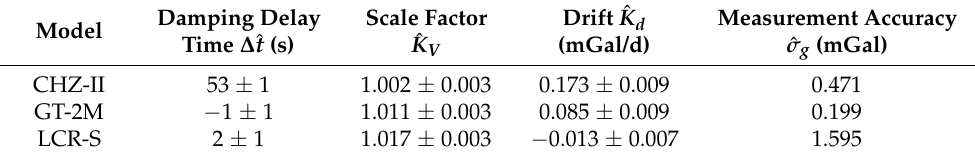
Table 1. Calibration results for three types of moving-base